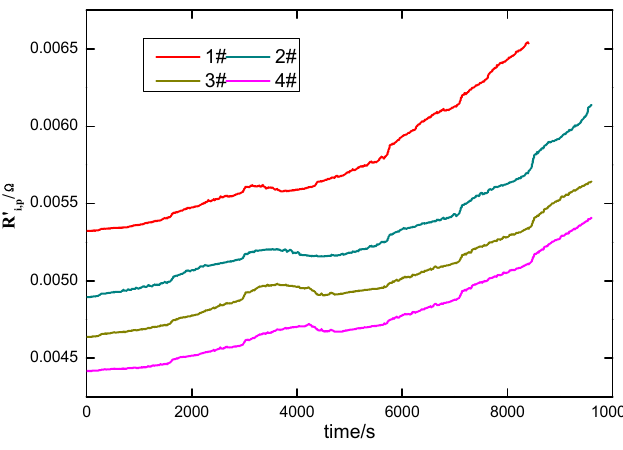
Figure 12. PCBG resistance vs. cell aging inconsistency fault.